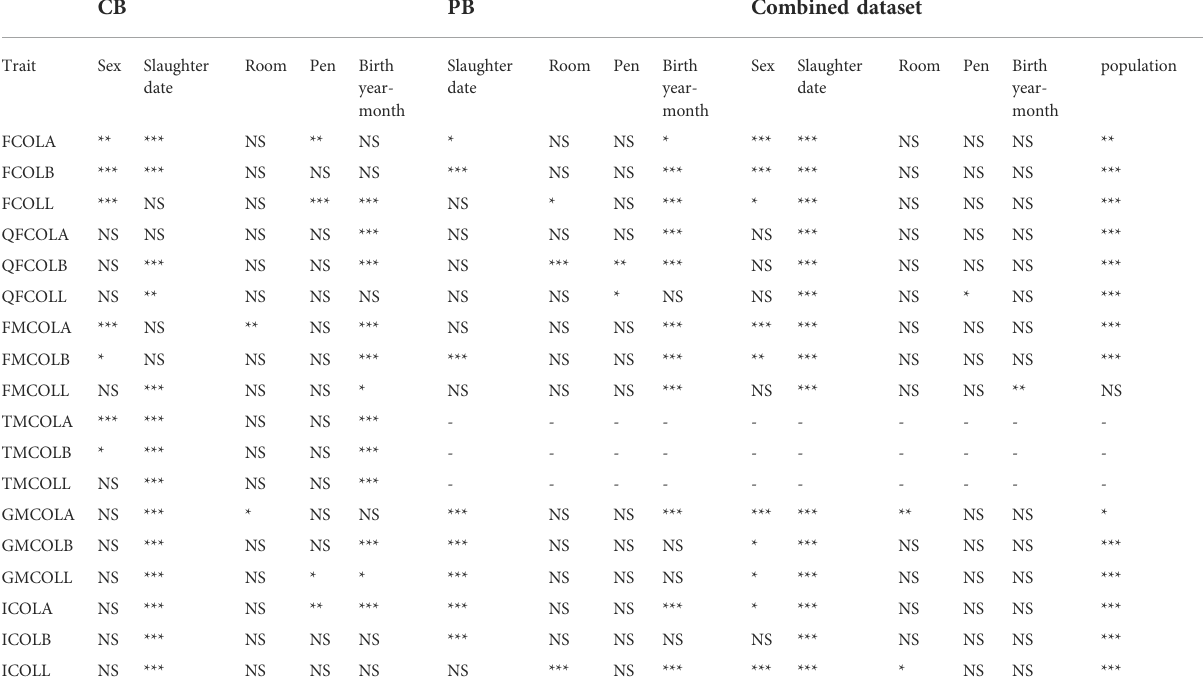
TABLE5Signi fi canceofthe fi xedeffects(sex, slaughterdate,room,pen, birthyear-month,andpopulation)included inthemixedmodel fordifferent datasets (CB, PB, and Combined dataset) for the pork color traits. CB PB Combined dataset Trait